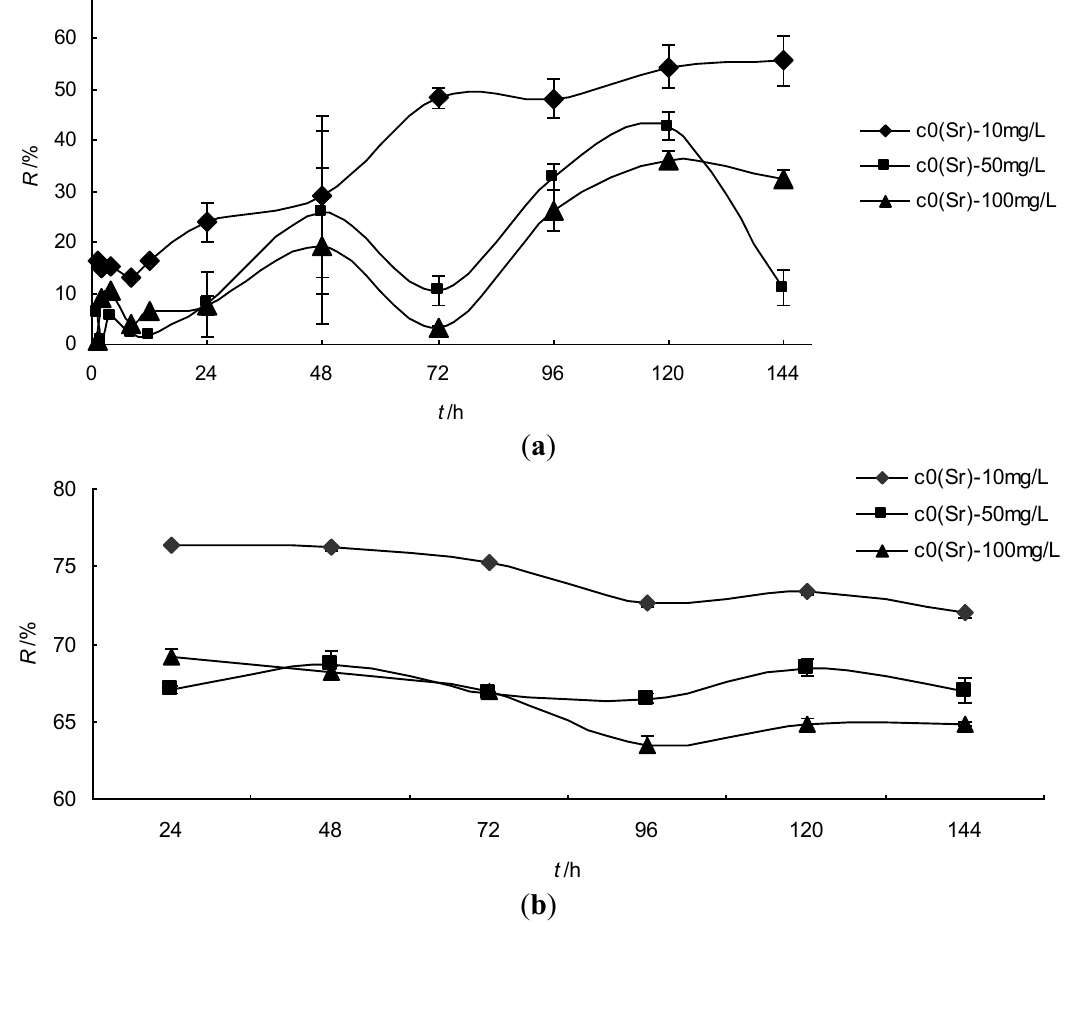
Figure 2. ( a ) The bioremoval ratio of strontium ions from a simple solution containing single strontium ions by S. spinosus under batch culture conditions; ( b ) The bioremoval ratio of strontium ions from simulated wastewater by S. spinosus under batch culture